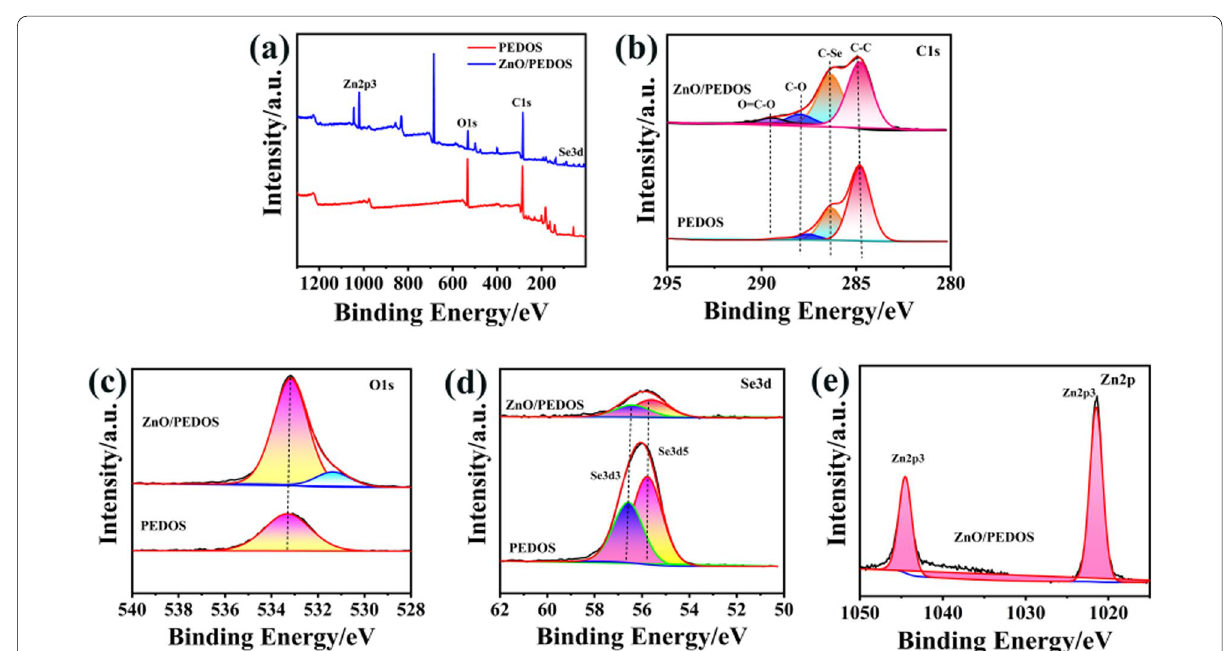
Fig. 3 XPS spectra of PEDOS, ZnO NRs/PEDOS composites. a Survey, b C1 s , c O1 s , d Se3 d , e Zn2